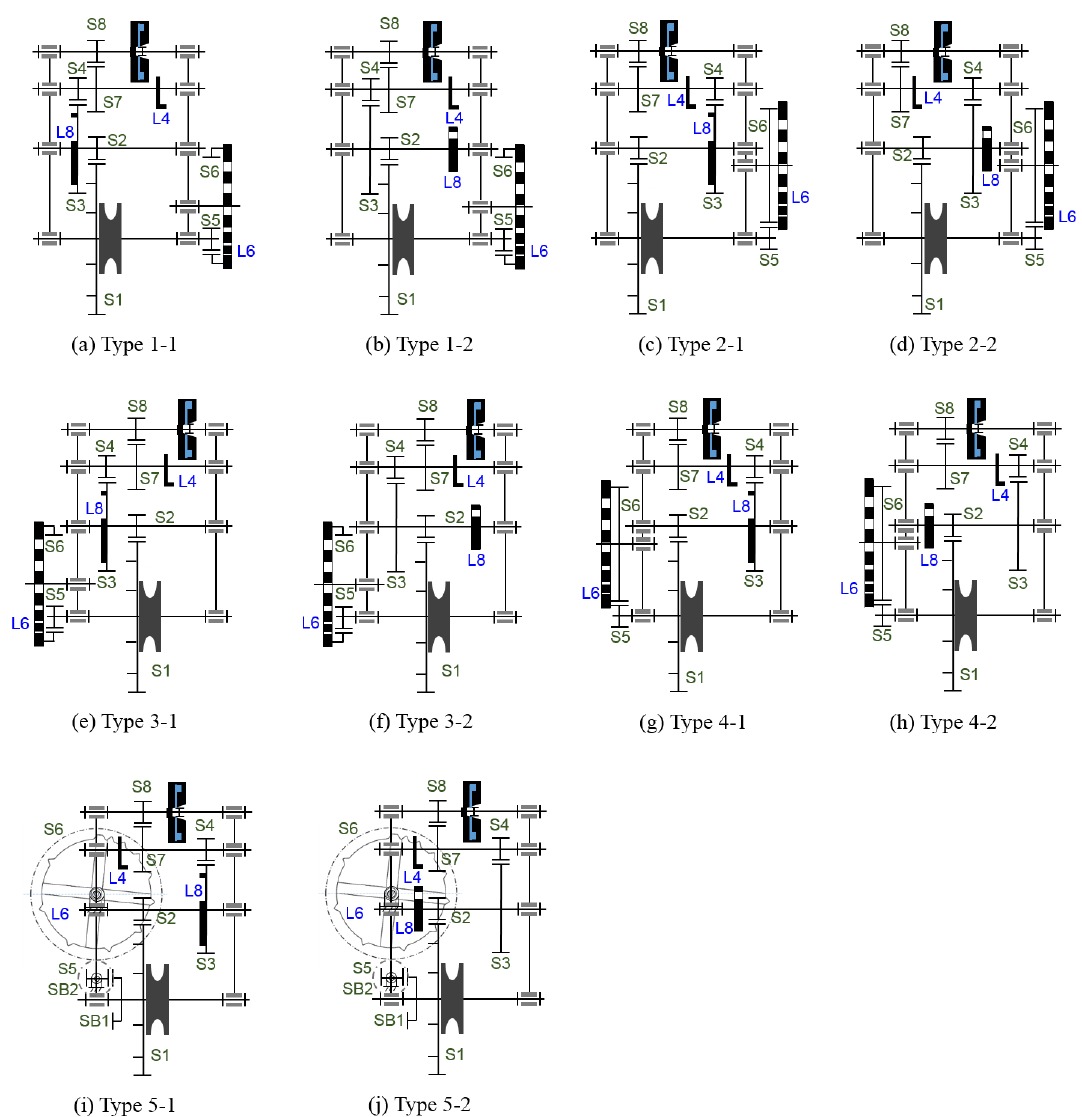
Figure 6. Types of striking trains in chamber